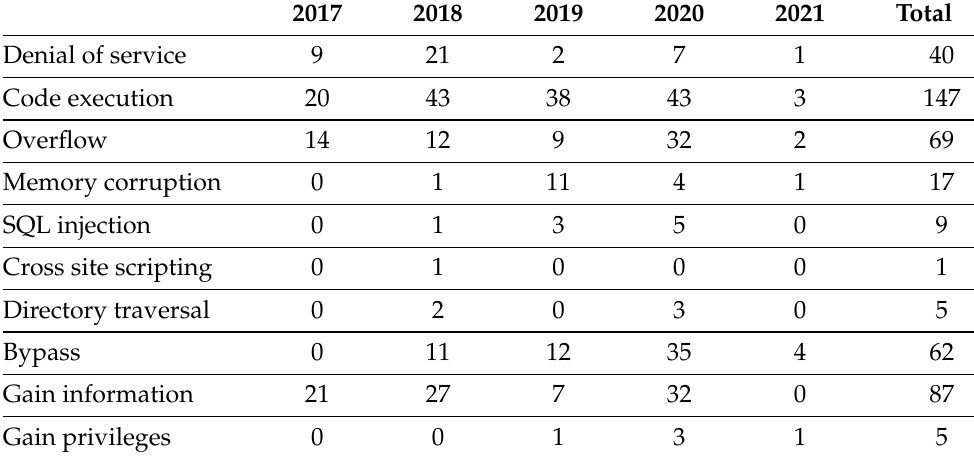
Table 4. Table 3. Android 8 vulnerabilities.